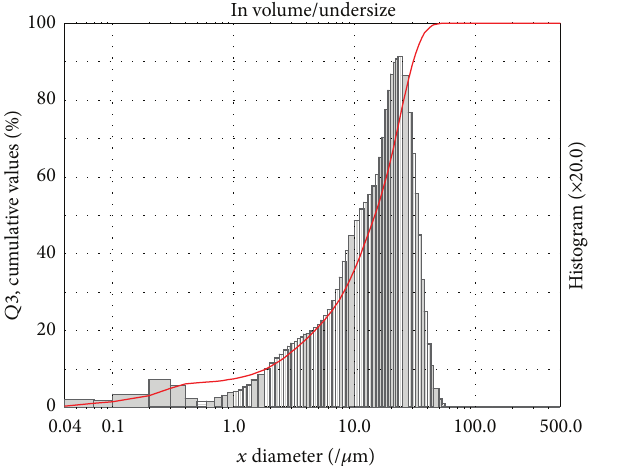
Figure 4: Particle size distribution of commercial calcium